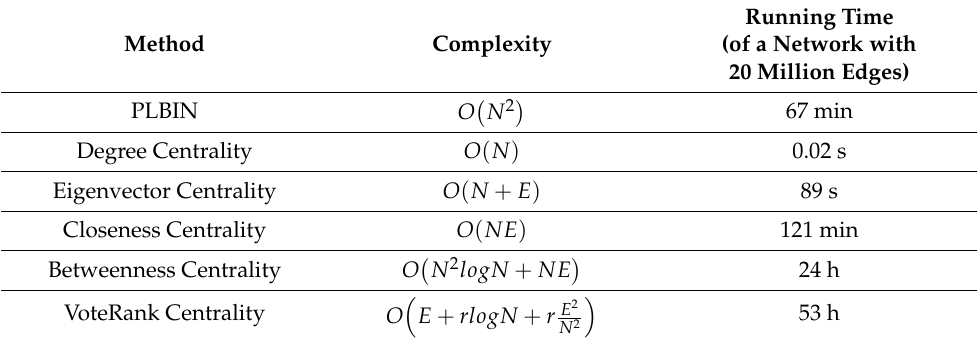
Table 3. Computational complexity and running time of each centrality method. N : the number of nodes (genes). E : the number of edges (gene associations).